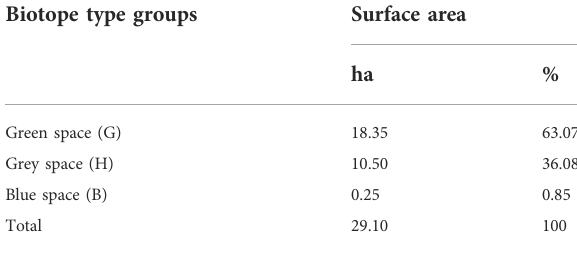
TABLE 1 Area of three biotope type groups in Riverside